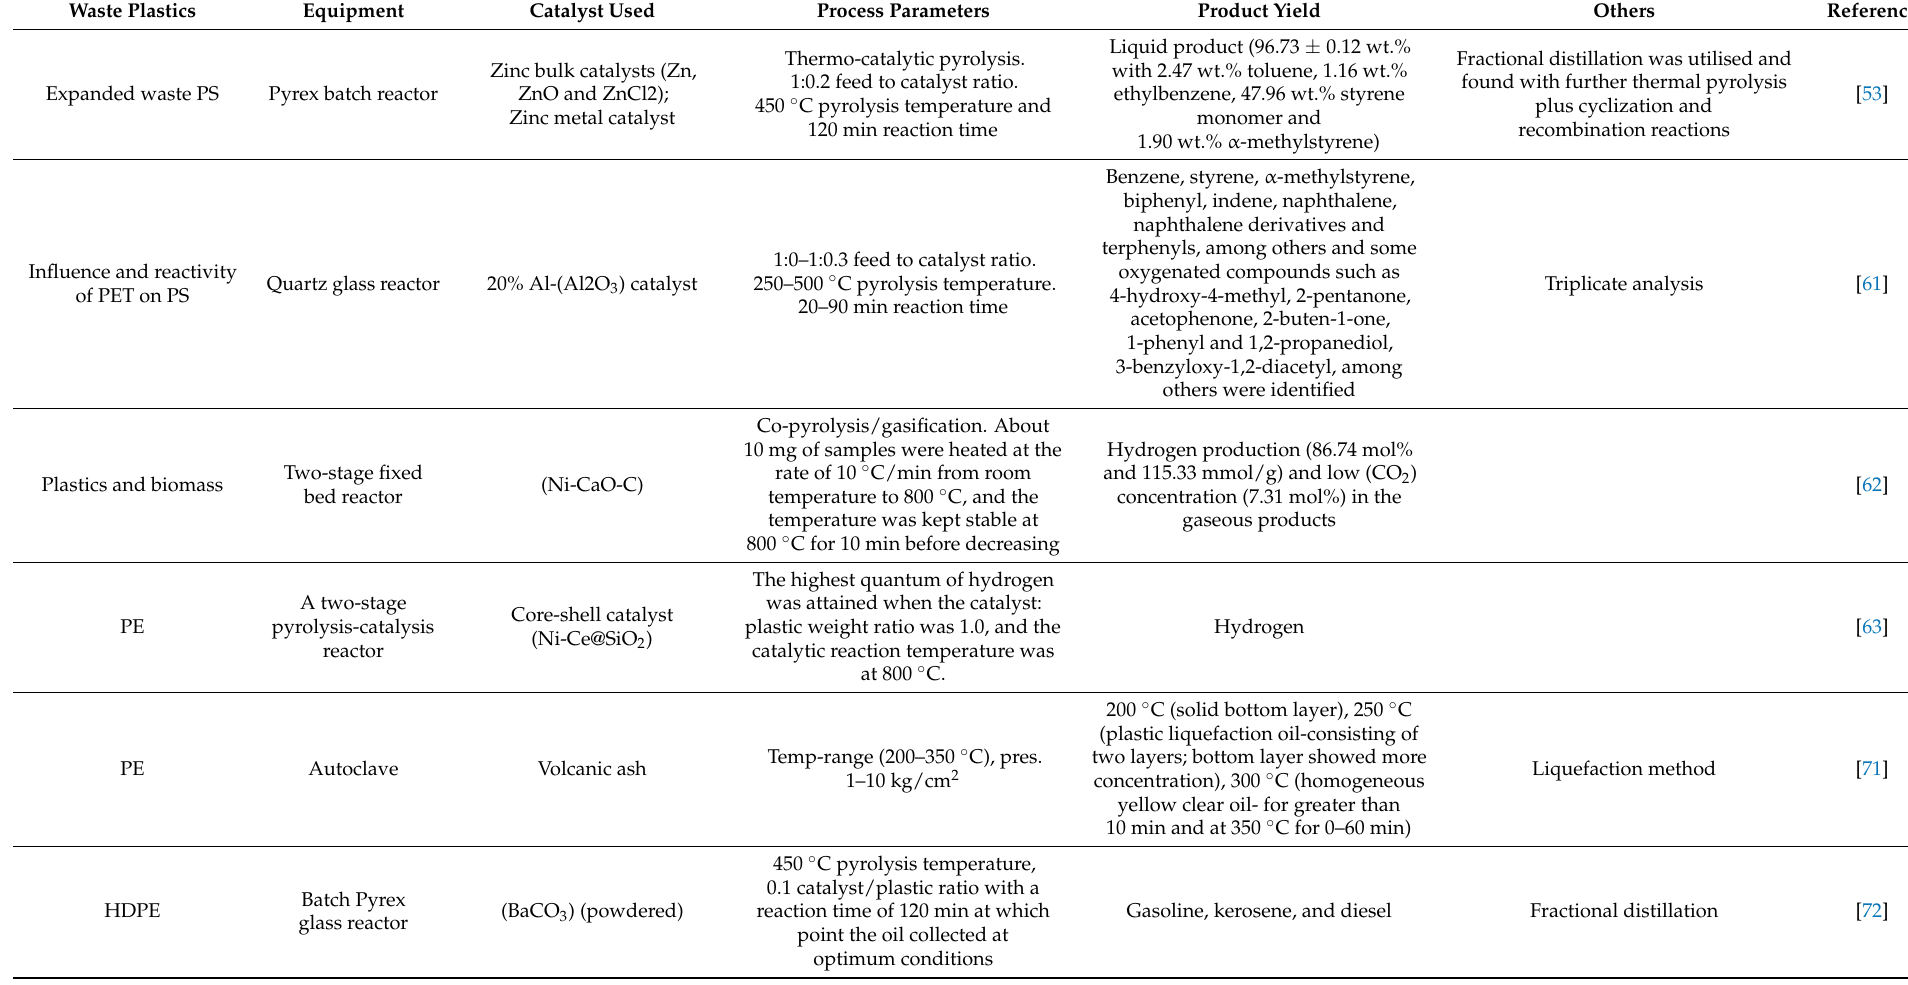
Table 1. Different heterogeneous catalysts utilised in a range of pyrolysis reactors, major process parameters, pyrolytic yields, and other